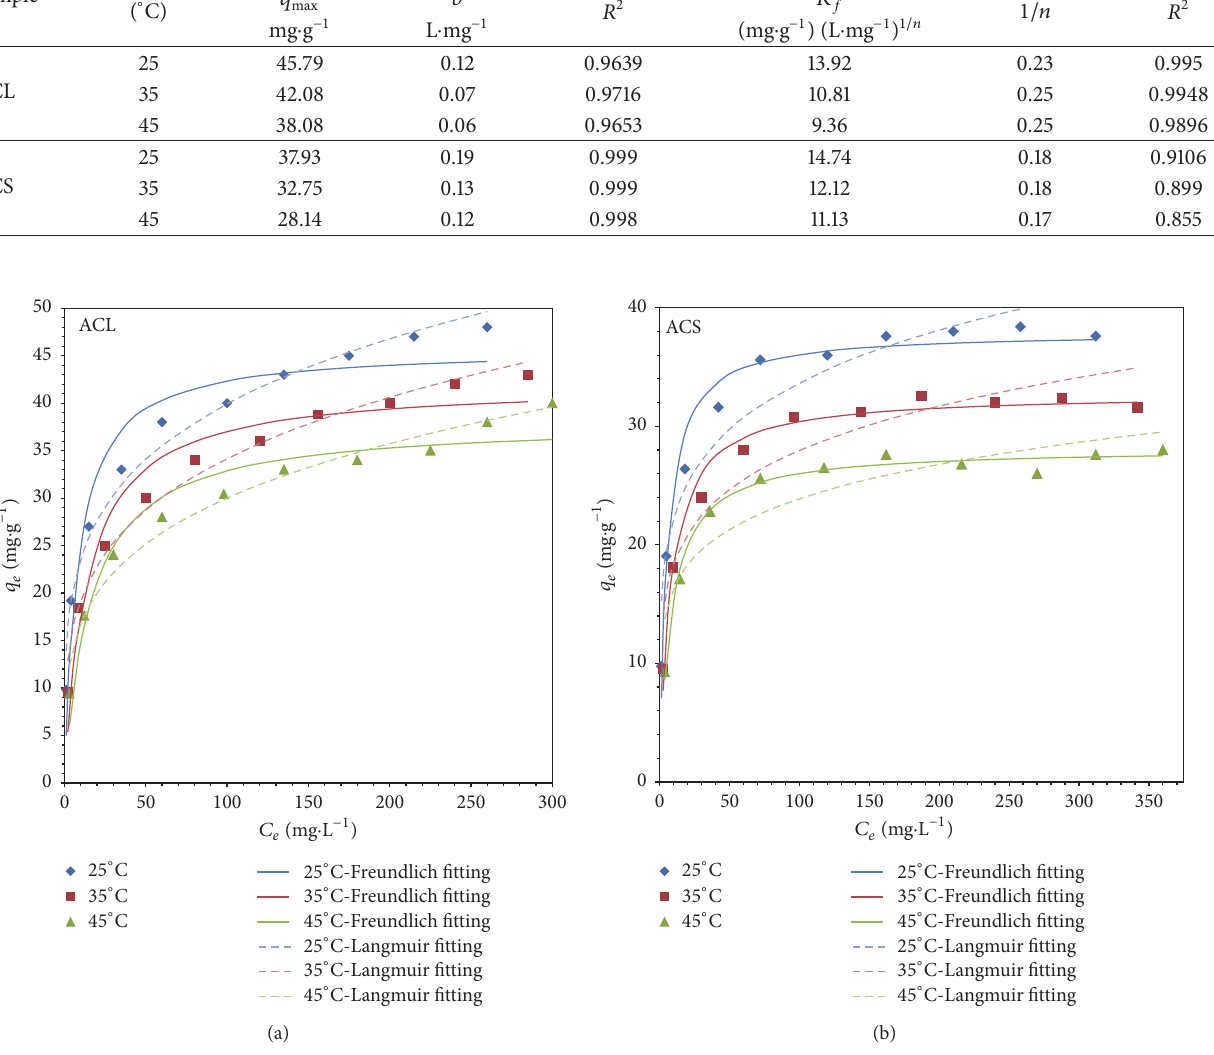
Table 3: Parameters of Langmuir and Freundlich adsorption models obtained from fitting of adsorption data at a different temperature. Temp Sample